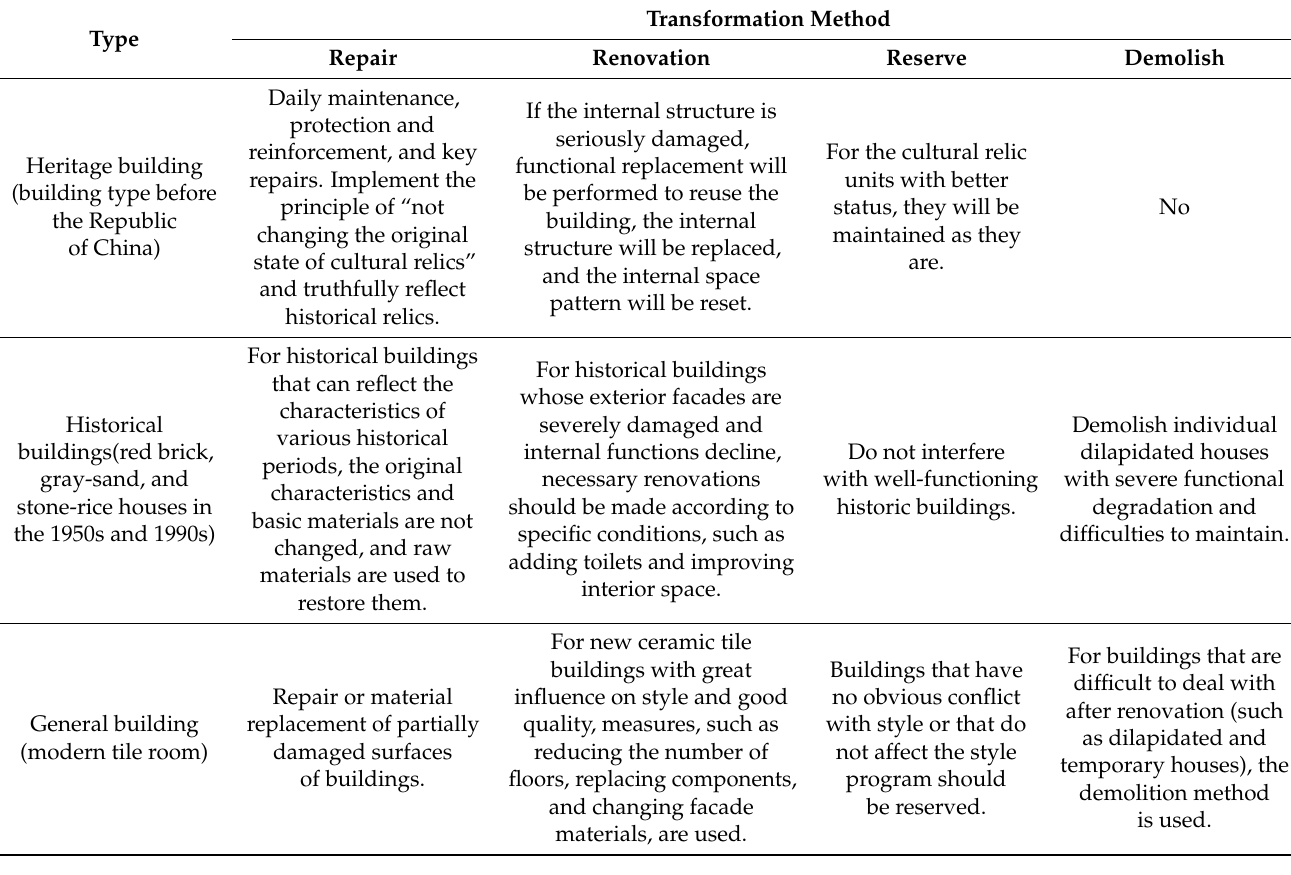
Table 2. Renovation mode of ancient town buildings.